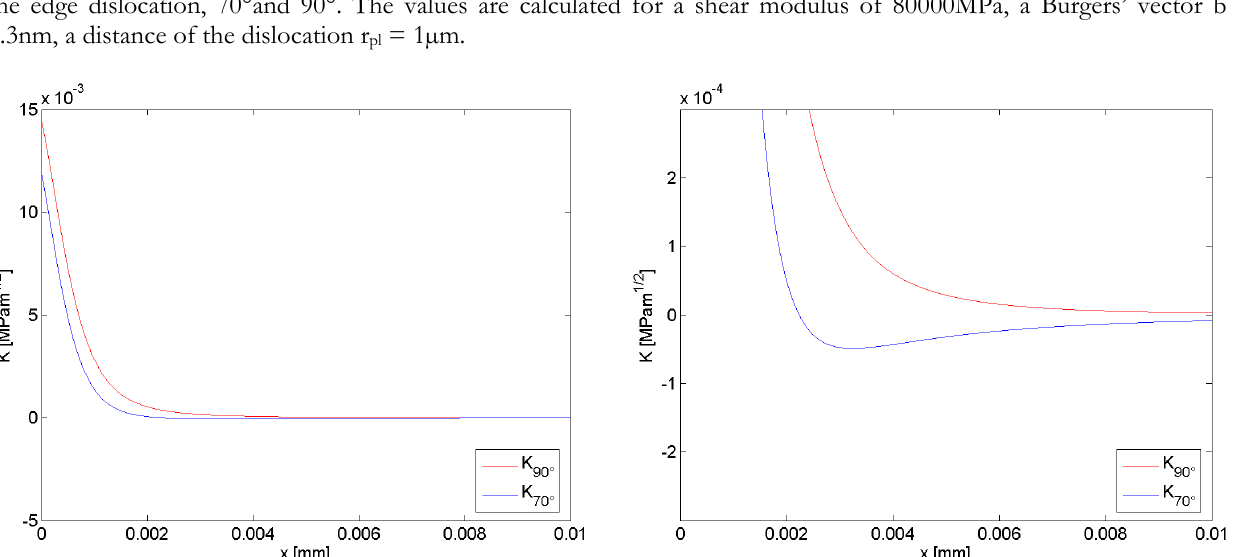
Figure 5: The stress intensity factors induced for 70° and 90° inclined dislocations as a function of the distance to the crack tip in the wake.